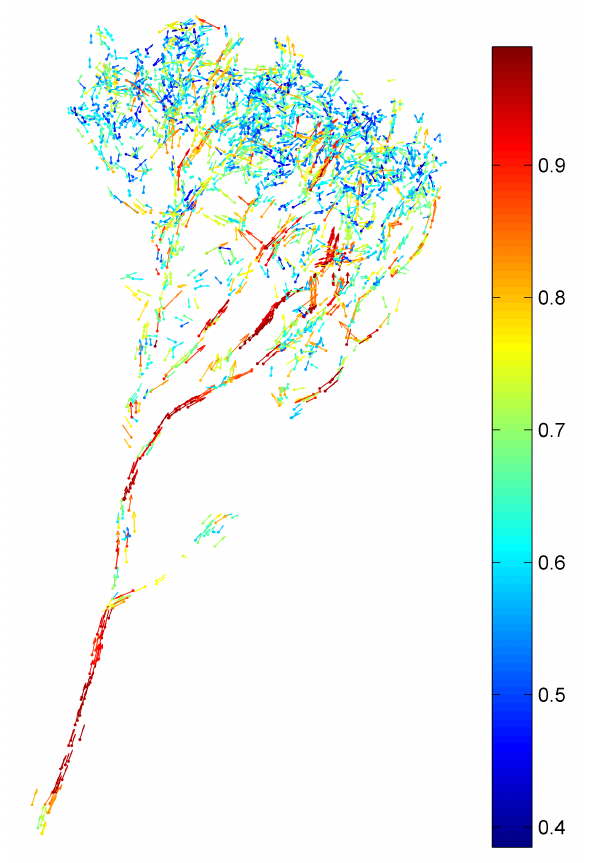
Figure 3: A tree coloured by normalized largest eigenvalue at each point. The arrows depict the directions of the corresponding